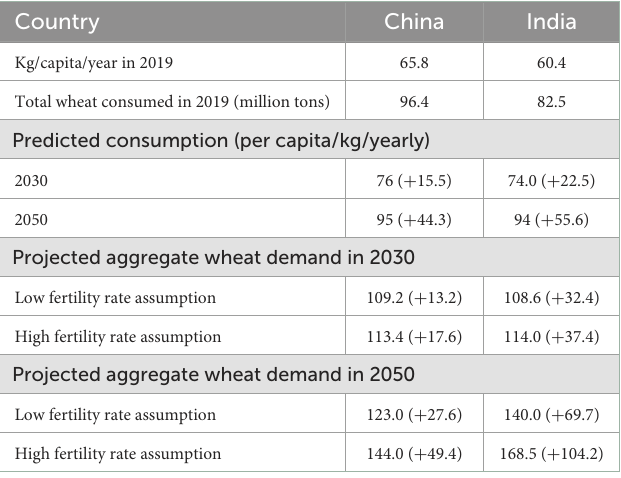
TABLE 6 Wheat consumption projection by considering population dynamics and based on predicted consumption in the sampled countries.